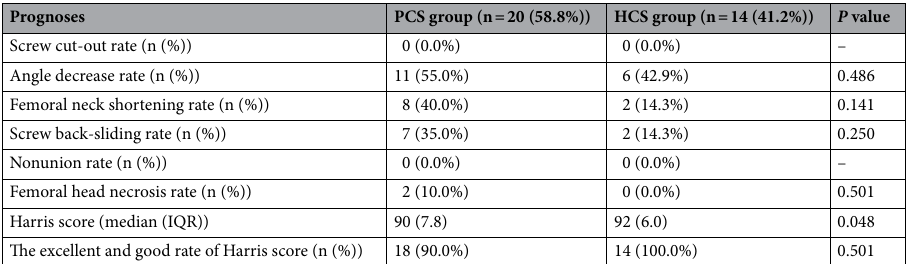
Table 8. Prognoses of patients with different internal fixation groups in non-displaced fractures. IQR stands for interquartile range.